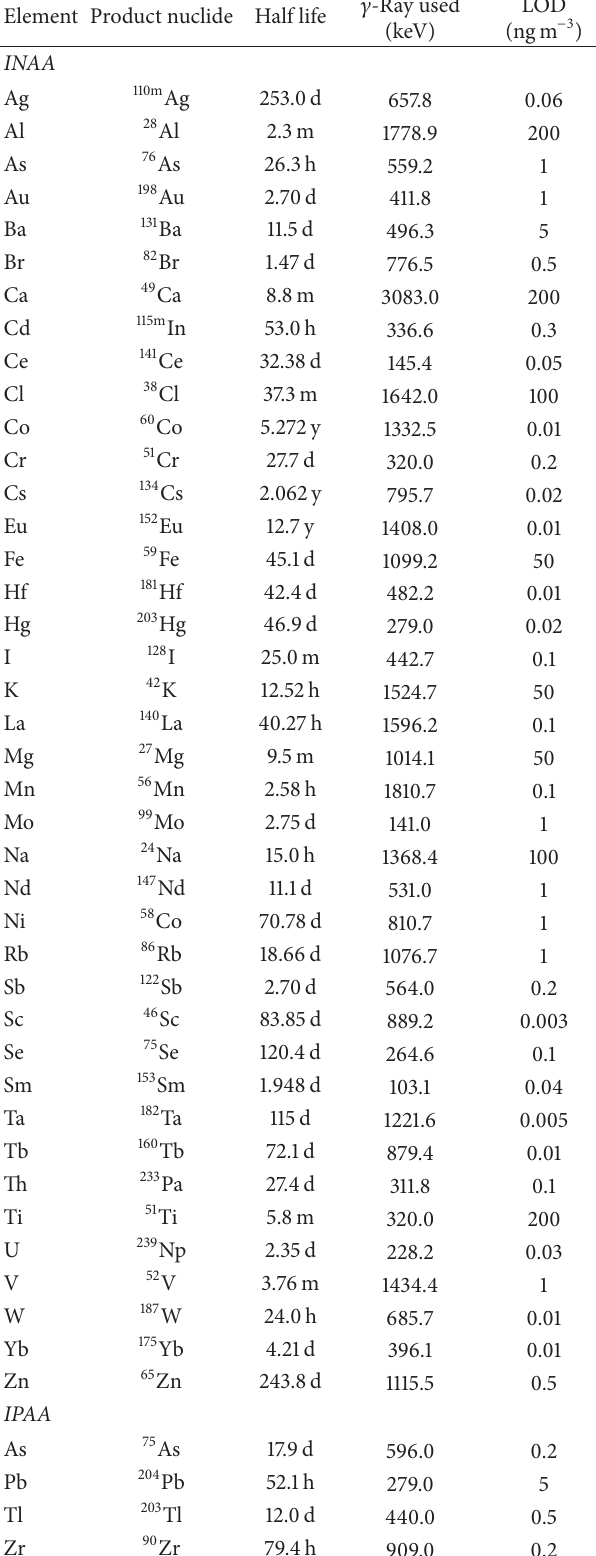
Table 1: Nuclear data and LOD of elements by INAA and IPAA (m: minutes; h: hours; d: days; y: years). LODs calculated according to [30]. Element Product nuclide Half